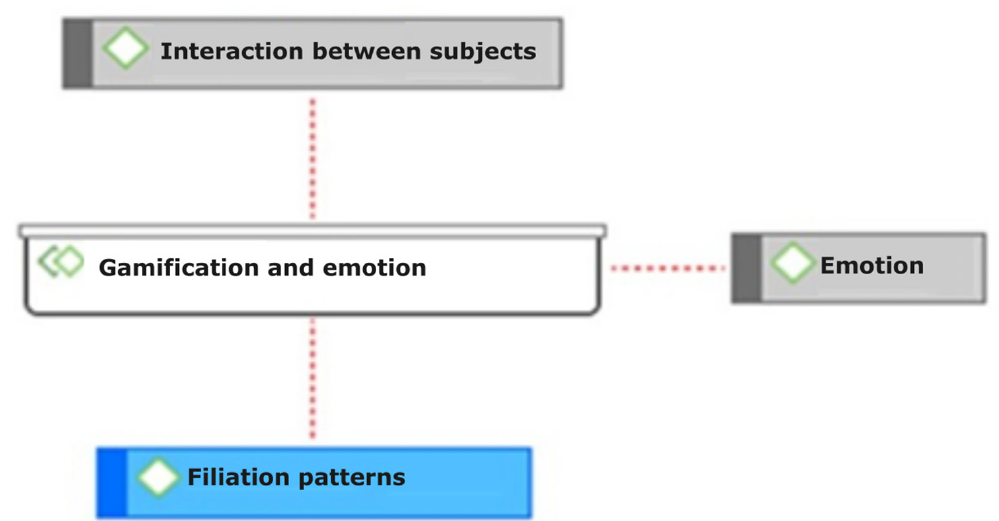
Figure 6. Edutainment and emotion. Source: Self-generated with the use of ATLAS.ti Software.